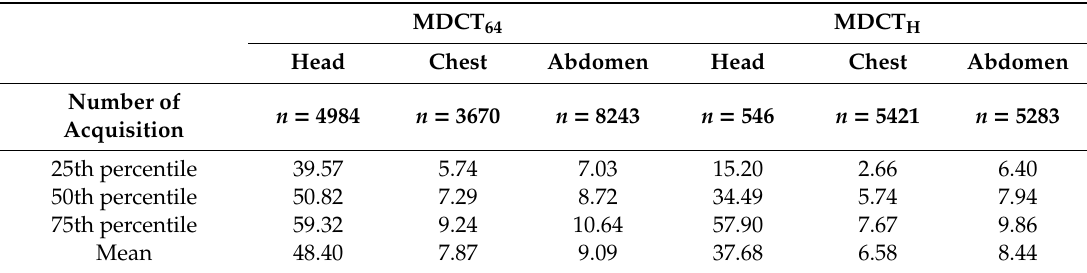
Table 1. Volume CT dose index (CTDI vol ) (mGy) from consecutive adult computed tomography (CT) examinations.